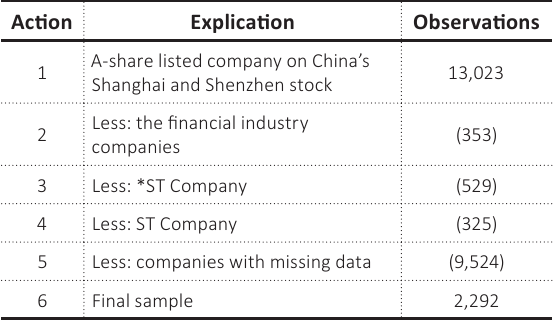
Table 1. Sample selection